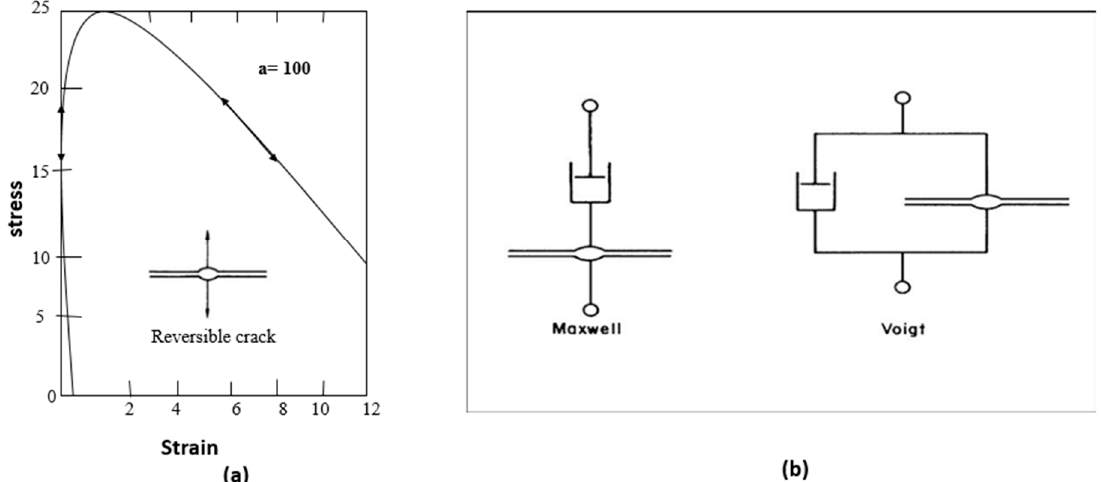
Figure 1. ( a ) The stress–strain response of a healing element is shown where the two parallel surfaces interact, modelled by an anharmonic non-bonded potential function. ( b ) Viscoelastic elements composing the healing element, in series (Maxwell) and in parallel (Voight). (Reproduced with permission) from [7]. Copyright: from The Royal Society of Chemistry, 2008. Figure above shows the reversible self-healing crack with basic phenomena of idealized element of self-healing, used in parallel or series with dashpots and elementary springs to the Maxwell or Voigt models, which shows yielding at critical strain.